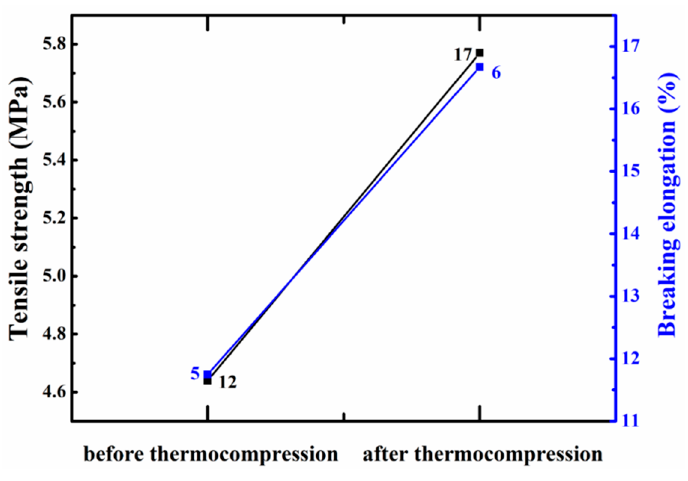
Figure 9. Tensile strength and breaking elongation of MC/PLA (1:1) membrane, before and after thermocompression at 140 °C and 10 MPa.